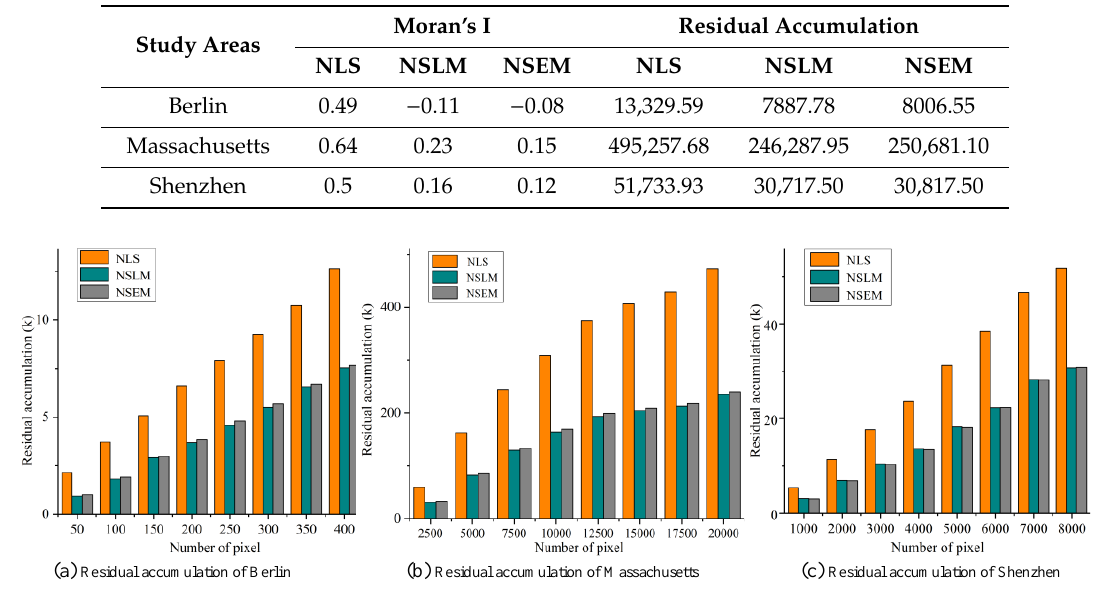
Figure 7. Accumulations of absolute residual of the three regression models in the three study areas.